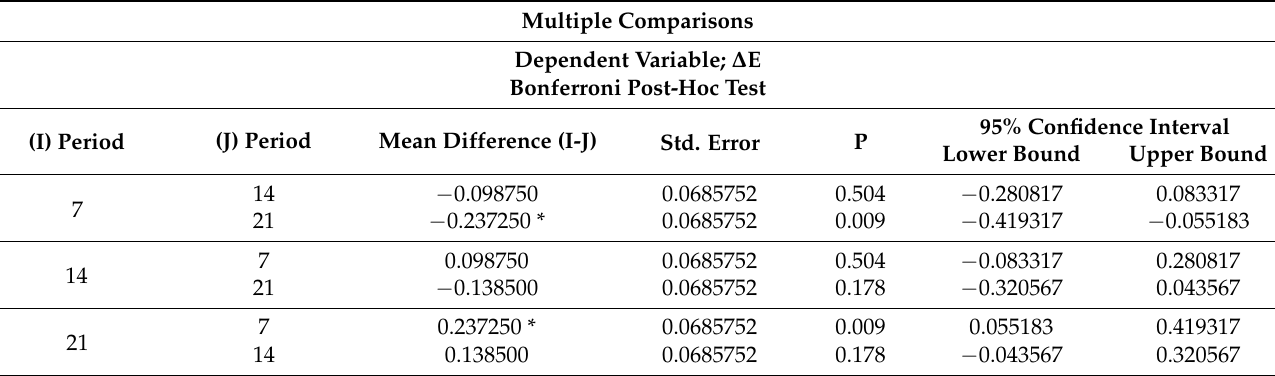
Table 3. Bonferroni post hoc test—multiple